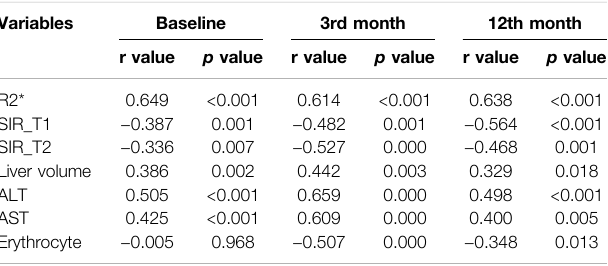
TABLE3| CorrelationanalysisbetweenserumferritinandMRImetricsandclinical laboratory indicators during thalidomide treatment. Variables